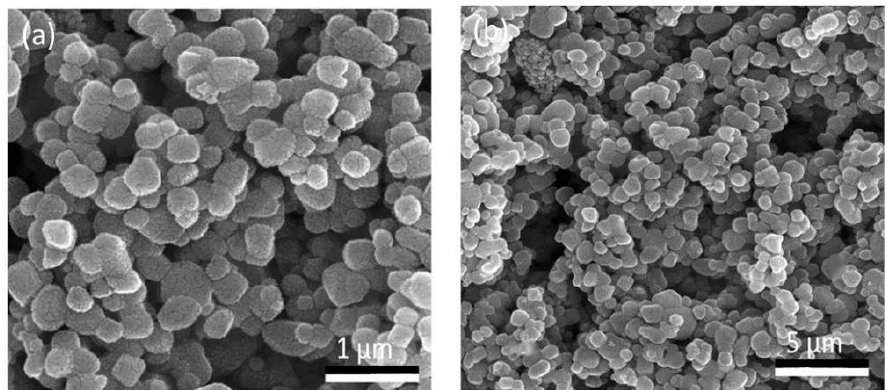
Figure 4. Scanning electron microscopic image of TiO 2 nanoparticles at ( a ) 1000× ( b ) 5000×.